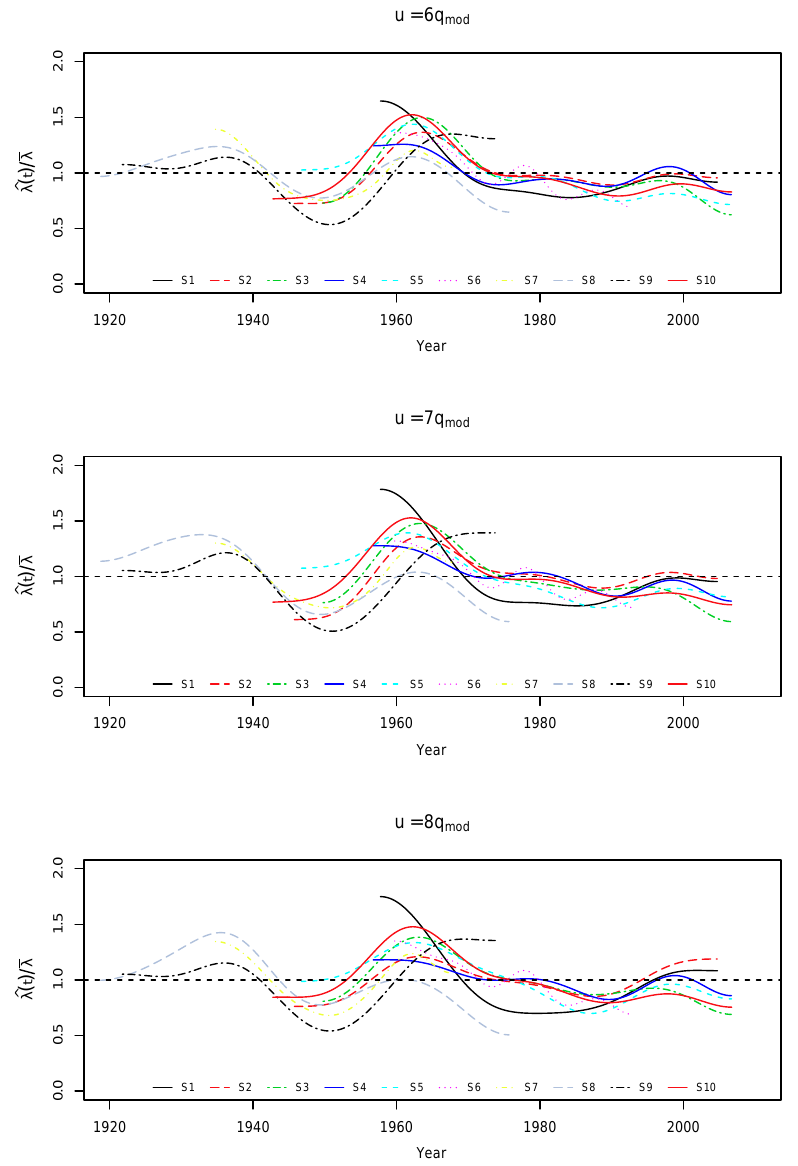
Fig. 9. Samples S1 to S10. Fluctuations of ˆ λ(t)/λ for three different threshold definitions. by a decrease in intensity until a minimum is reached in the late 1940s (also visible in graph S7); (c) the graphs with data until the late 1990s and 2000s exhibit lower occurrence rates in the more recent